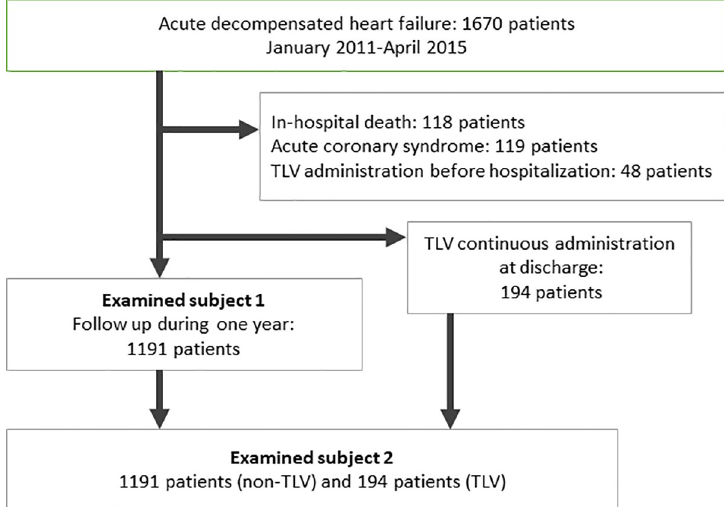
Fig 1. Patient flow chart of the present study. Examined subject 1 included a total of 1191 patients to investigate the risk heart failure-related re-hospitalization. Examined subject 2 investigated the effect of continuous administration of Tolvaptan (TLV), and included the 1191 patients from examined subject 1, as well as the patients who received continuous administration of TLV when they were discharged from the hospital (n = 194).